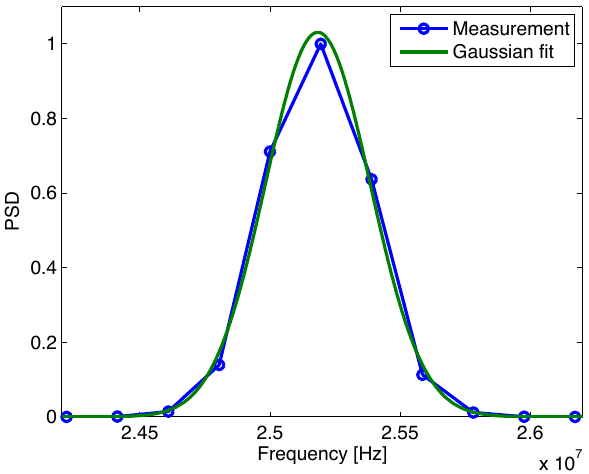
Fig. 8. Example of ensemble averaged Doppler spectrum together with a Gaussian fit obtained at a nominal wind speed of 50ms − 1 .